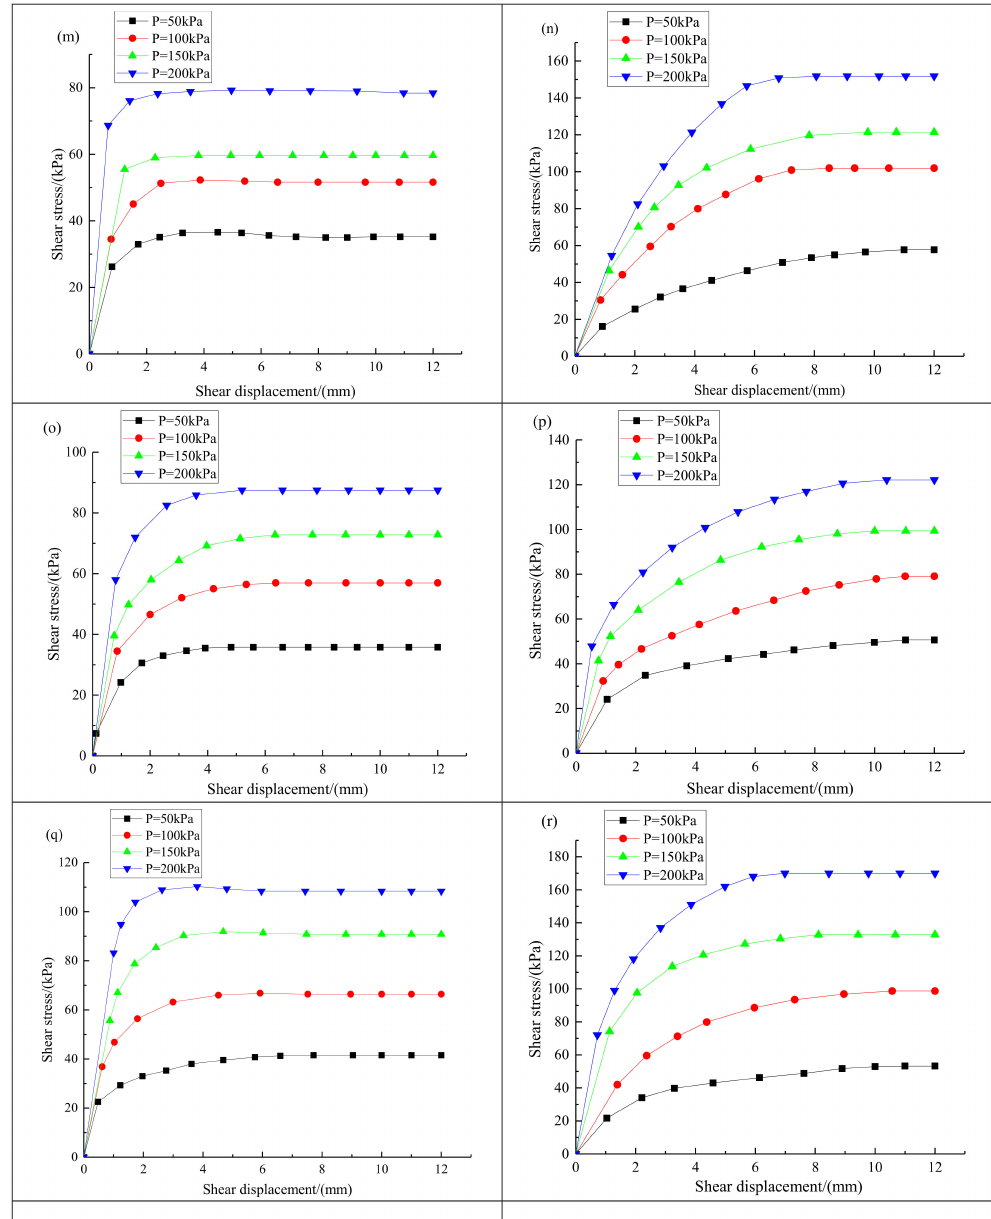
Figure 4. Relationship curve between the shear stress and the shear displacement for the geomembrane and di ff erent solid wastes and soils: ( a ) geomembrane with smooth surface and desulfurized gypsum; ( b ) geomembrane with rough surface and desulfurized gypsum; ( c ) geomembrane with smooth surface and fly ash; ( d ) geomembrane with rough surface and fly ash; ( e ) geomembrane with smooth surface and red mud; ( f ) geomembrane with rough surface and red mud; ( g ) geomembrane with smooth surface and mercury slag; ( h ) geomembrane with rough surface and mercury slag; ( i ) geomembrane with smooth surface and lead–zinc slag; ( j ) geomembrane with rough surface and lead-zinc slag; ( k ) geomembrane with smooth surface and manganese slag; ( l ) geomembrane with rough surface and manganese slag; ( m ) geomembrane with smooth surface and silica fume; ( n ) geomembrane with rough surface and silica fume; ( o ) geomembrane with smooth surface and clay; ( p ) geomembrane with rough surface and clay; ( q ) geomembrane with smooth surface and sand; ( r ) geomembrane with rough surface and